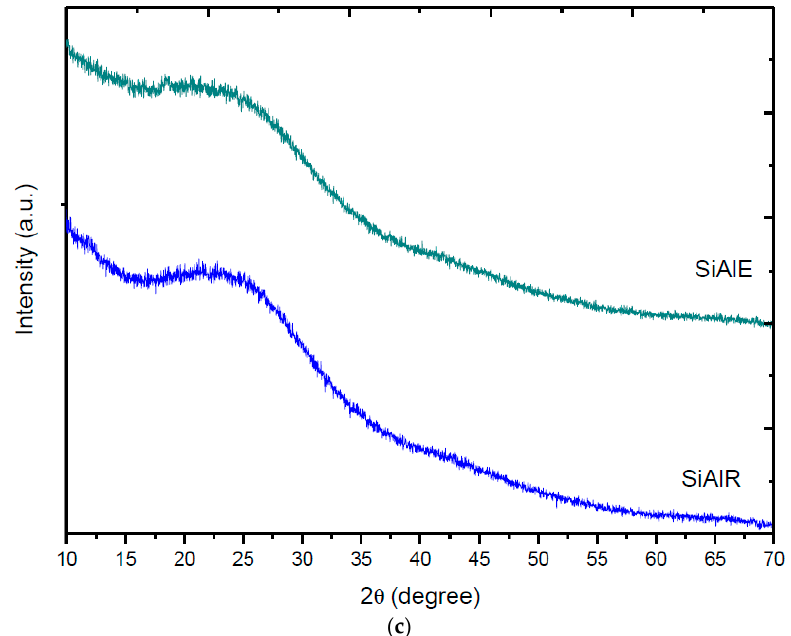
Figure 3. X ‐ ray powder diffraction (XRD) patterns of the solids studied: ( a ) as ‐ prepared ( b) calcined Figure 3. X-ray powder diffraction (XRD) patterns of the solids studied: ( a ) as-prepared ( b) calcined and ( c ) modified samples. and ( c ) modified